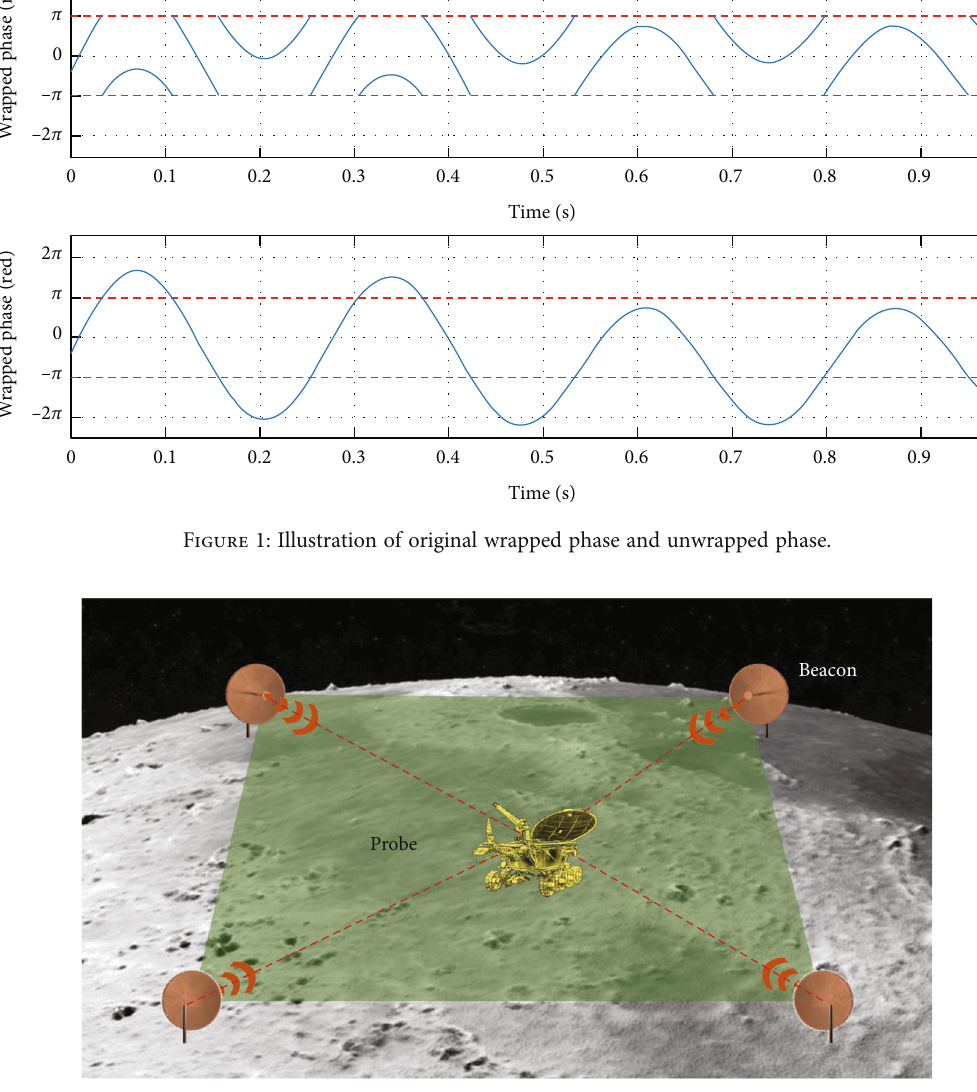
Figure 2: Positioning scene for lunar probe